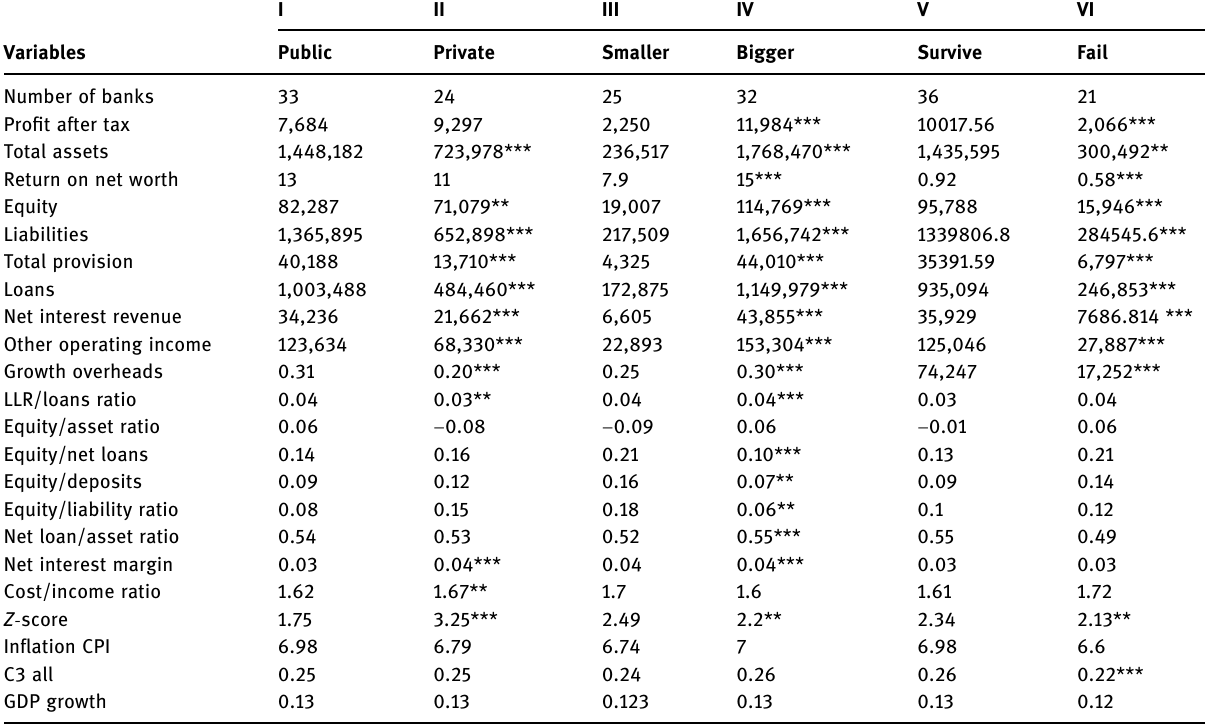
Table 5: Descriptive statistics of accounting pro fi les of public versus private banks, smaller versus bigger banks, and survived versus